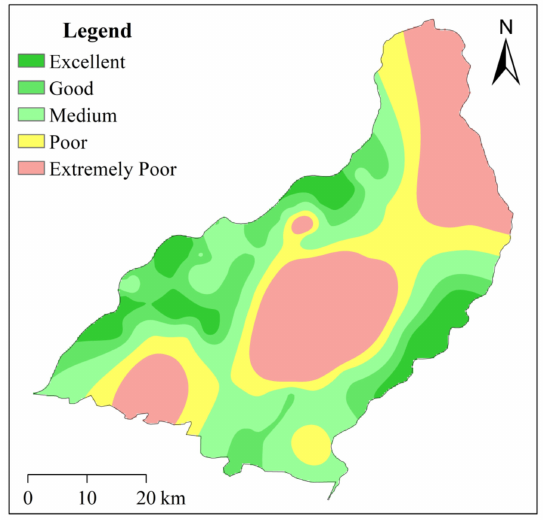
Figure 9. Groundwater EWQI zoning map of the Shizuishan